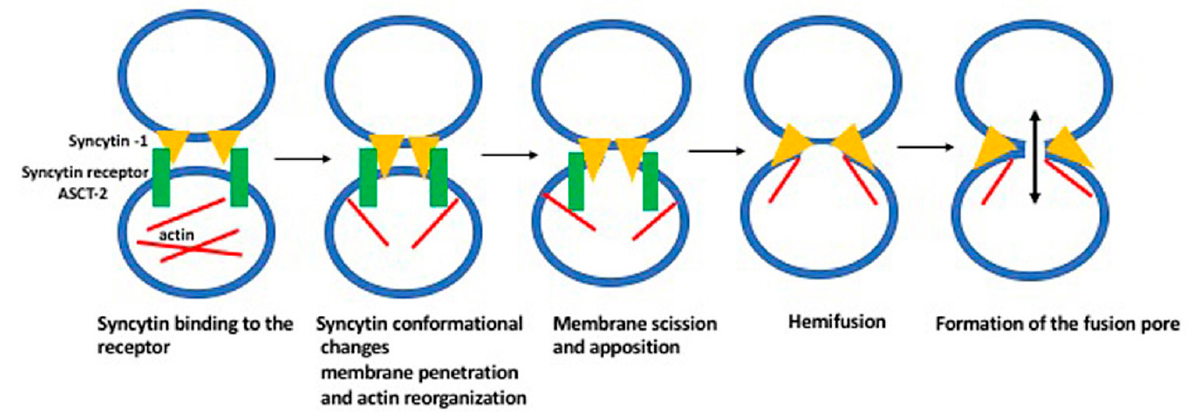
Figure 2. The consecutive steps in cell fusion.